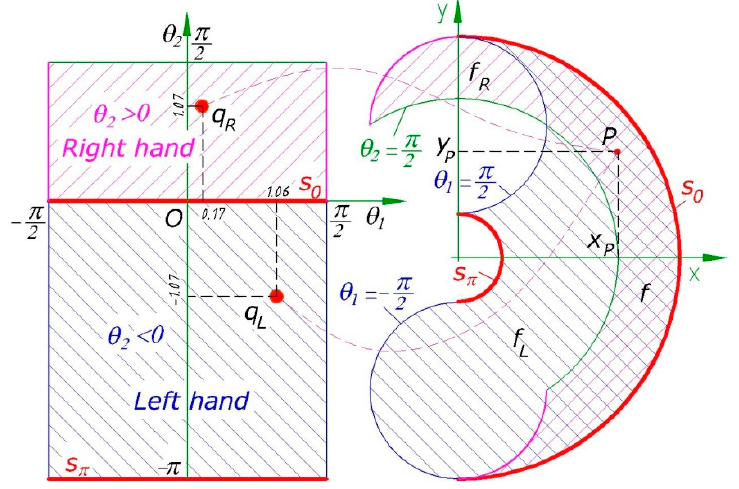
Figure 12. Configuration and workspace of a RR robot.